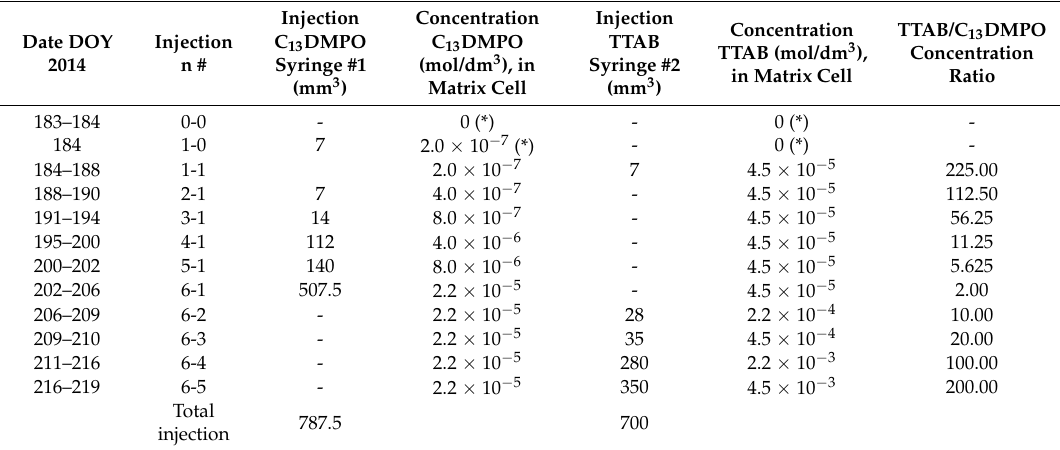
Table 1. Sequence of surfactant injections and concentrations in the matrix